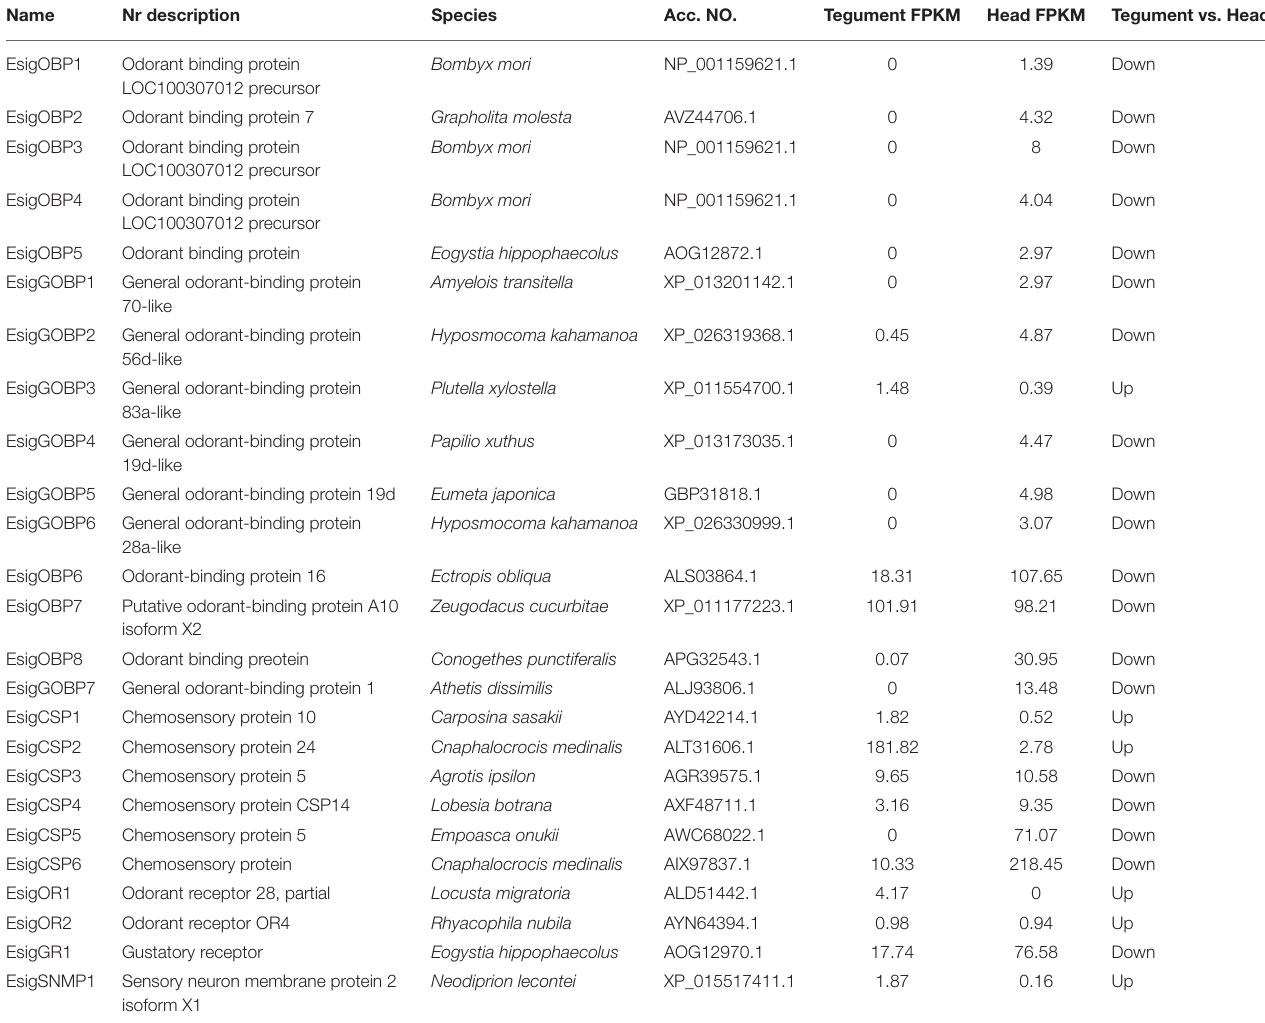
TABLE 1 | Best blastx hits for odorant-binding proteins (OBPs), chemosensory proteins (CSPs), odorant receptors (ORs), gustatory receptors (GRs), and sensory neuron membrane proteins (SNMPs) of Endoclita signifier